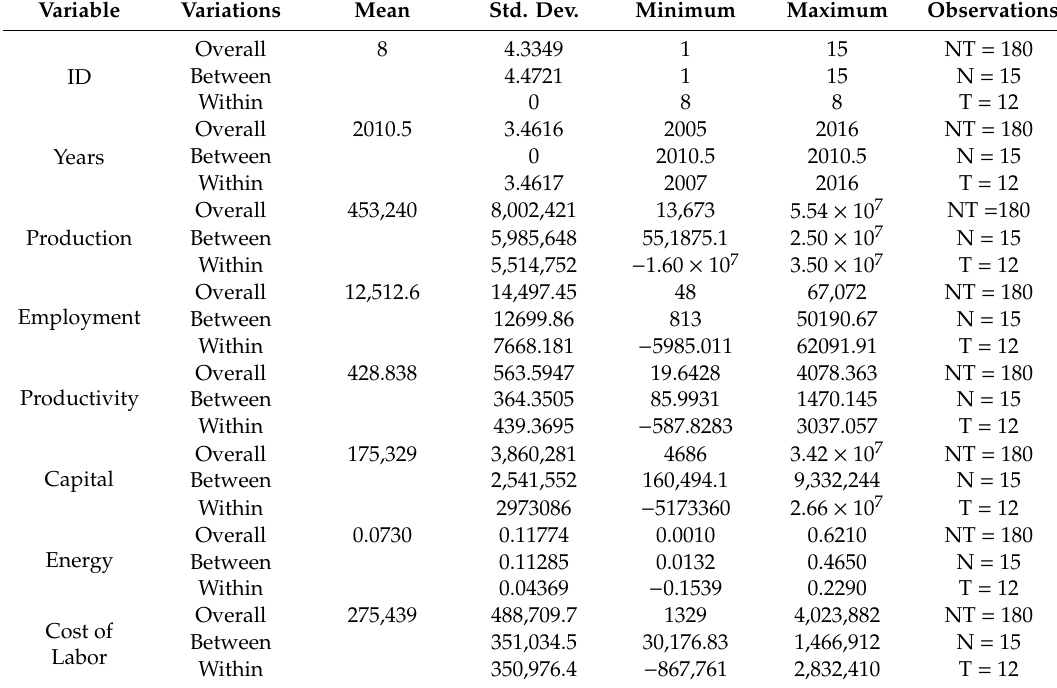
Table 3. Summary statistics of the variables of